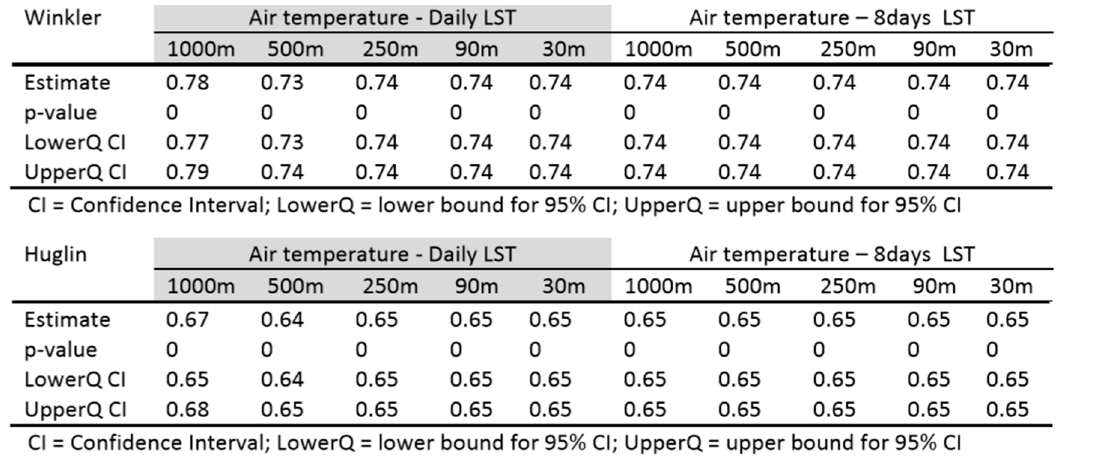
Figure A3. Table of Pearson correlation coefficients, computed between bioclimatic indices values from air temperature and LST, and statistical significance of the associated F ‐ test.